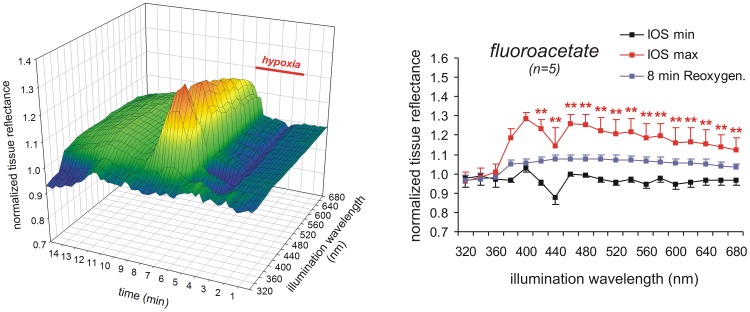
Glial poisoning does not oppose the generation of the IOS.Pretreatment of slices with FAc (5 mM) markedly intensified the reflectance increase during HSD. The nadir at 440 nm was dampened and the posthypoxic recovery slowed down.